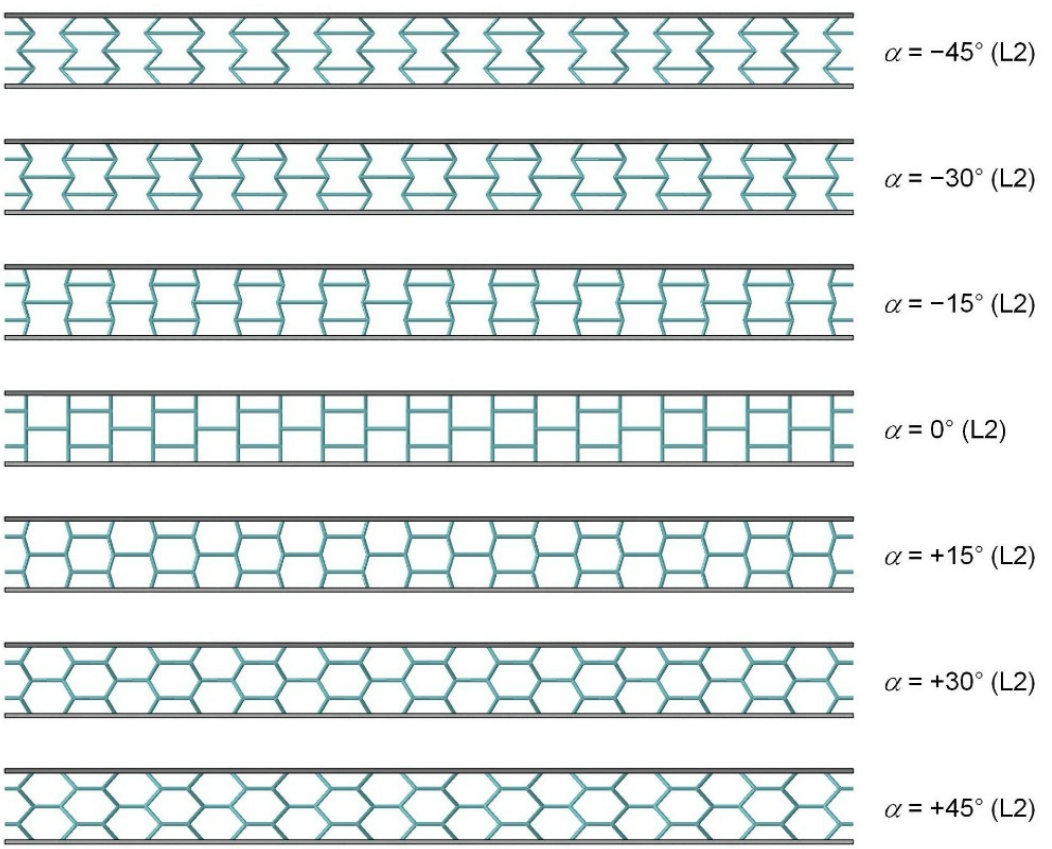
Figure 10. Cell shape changes of 3D lattice cores with variations in the grid cell angle α (side view in parallel projection).